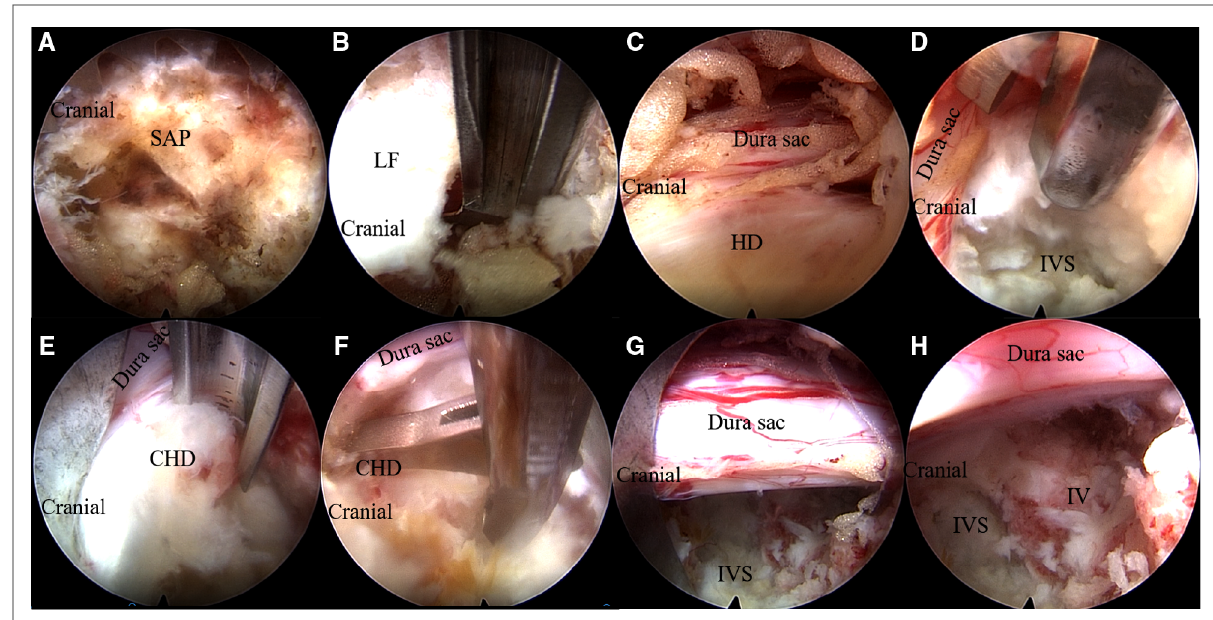
FIGURE 2 Main surgical procedures under endoscope. ( A ) The exposure of SAP and resection of SAP with a fully visualized trepan. ( B ) The ligamentum fl avum ventral to the articular processes was resected with a Kerrison rongeur. ( C ) Exposure of the herniated disc and compressed dura sac. ( D ) Resection of the degenerated nucleus pulposus in the intervertebral space and the intervertebral disc protruded into the spinal canal with punch forceps. ( E ) Removal of the calci fi ed herniated disc and ossi fi ed posterior longitudinal ligament at the posterior margin of the caudal vertebra with a chisel. ( F ) Removal of the calci fi ed herniated disc at the posterior margin of the cranial vertebra with punch forceps. ( G,H ) Complete decompression of dura sac at the intervertebral space level and caudal side. SAP, superior articular process; LF, ligamentum fl avum; HD, herniated disc; CHD, calci fi ed herniated disc; IV, inferior vertebra; IVS, intervertebral